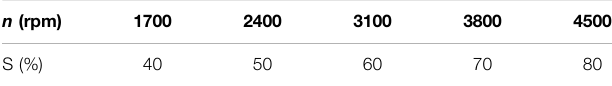
TABLE 2 | The relationship between motor speed n and accelerator pedal opening S.